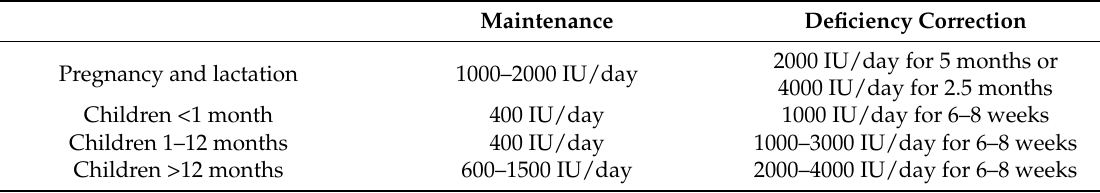
Table 1. Recommended vitamin D supplements for maintaining normal vitamin D levels or for correcting deficiencies in pregnant and lactating women, infants, and